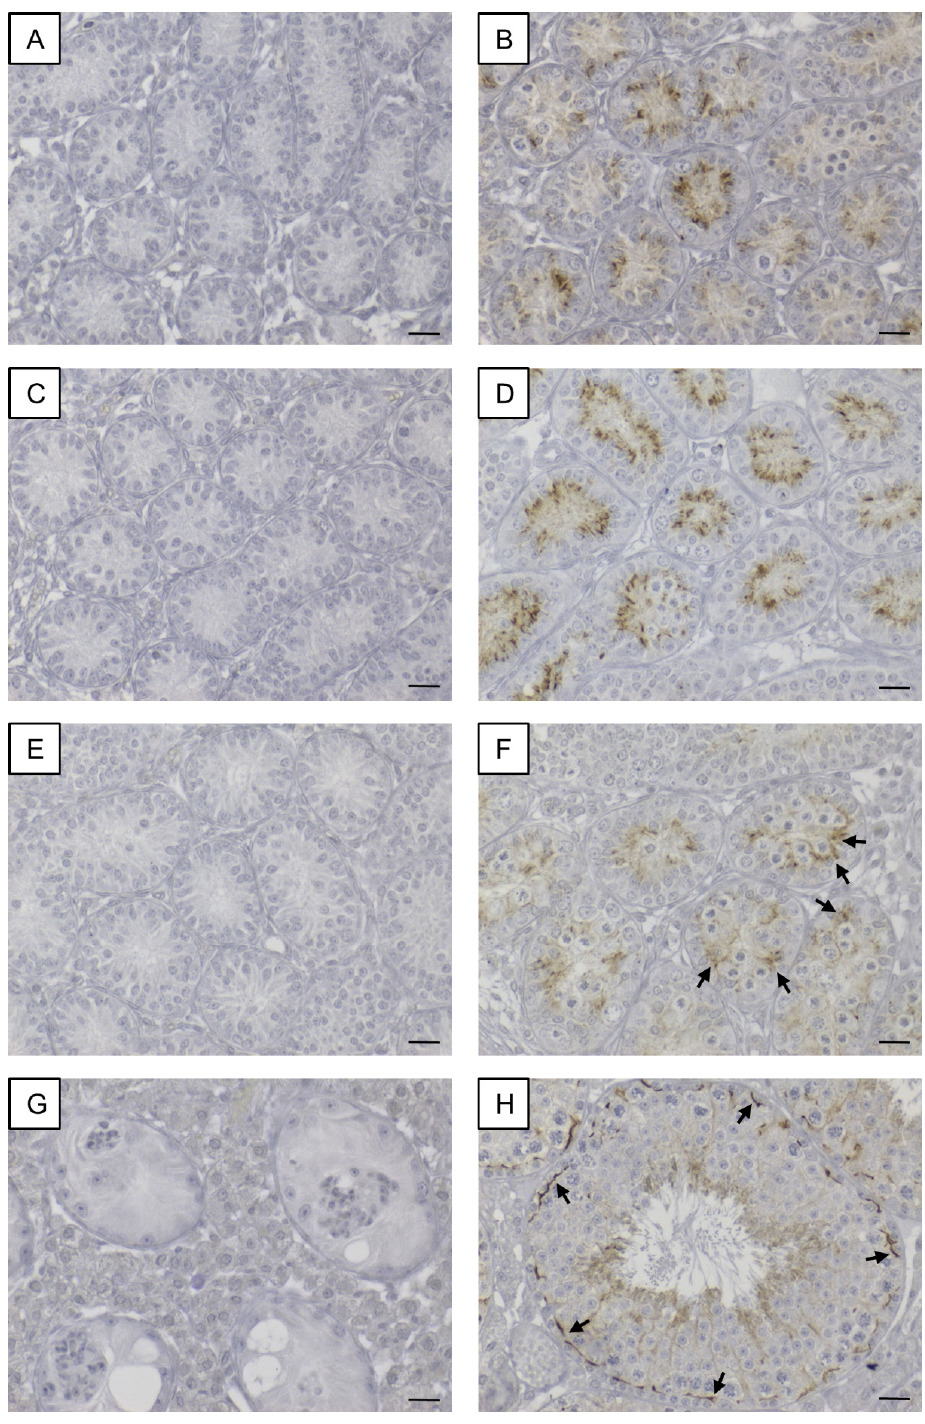
Figure 2. Immunohistochemical staining for Cx43. Testicular samples from SCCx43KO mice are shown on the left hand site ( A,C,E,G ) in comparison to testicular sections from WT littermates on the right hand site ( B,D,F,H ) at different ages ( A+B : 8 days p.n., C+D : 10 days p.n., E+F : 12 days p.n. and G+H : adult). Within the seminiferous tubules of SCCx43KO mice, no Cx43 staining was observable in all age groups. ( B+D ) A cytoplasmic signal for Cx43 was detectable in Sertoli cells of WT animals. ( F ) Cx43 immunoreaction weakened in the Sertoli cell cytoplasm of 12-day-old WT mice and shifted in the direction of the location of the future blood-testis-barrier (arrows). ( H ) In adult WT mice, Cx43 expression was observable at the basal third of the seminiferous epithelium (arrows). Cx43: connexin 43, KO: knockout, p.n.: post-natum, SCCx43KO: Sertoli cell-specific Cx43 knockout, WT: wild type, scale bars: 20 µ m, numerical aperture: